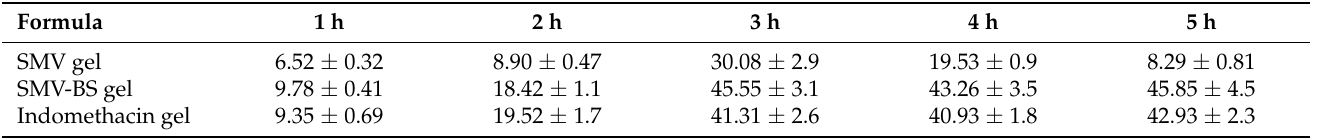
Table 5. Percentage swelling inhibition elicited by various SMV formulations.